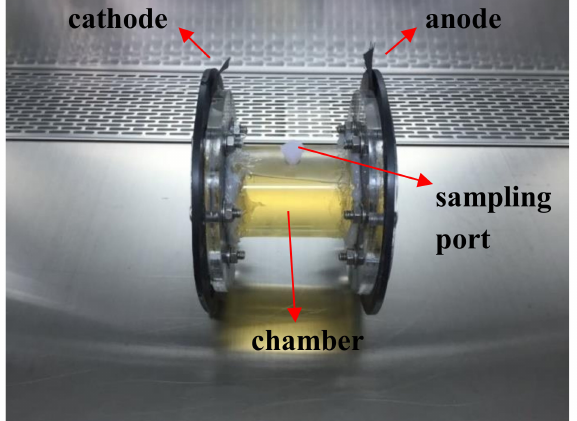
Figure 1. Photography of the membrane-free air-breathing cathode single-chamber microbial fuel cells